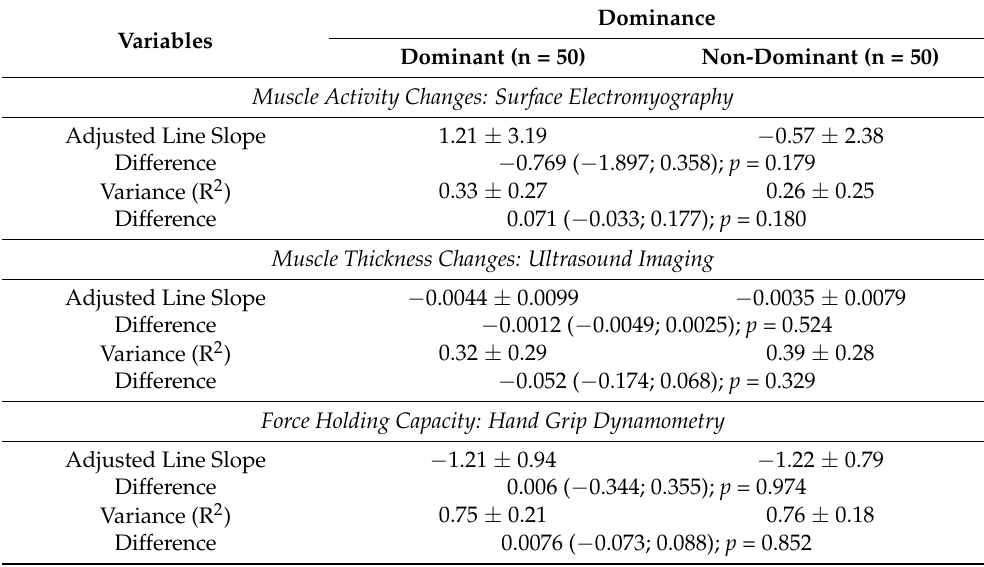
Table 5. Fatigue assessments with EMG, US and dynamometry by dominance.